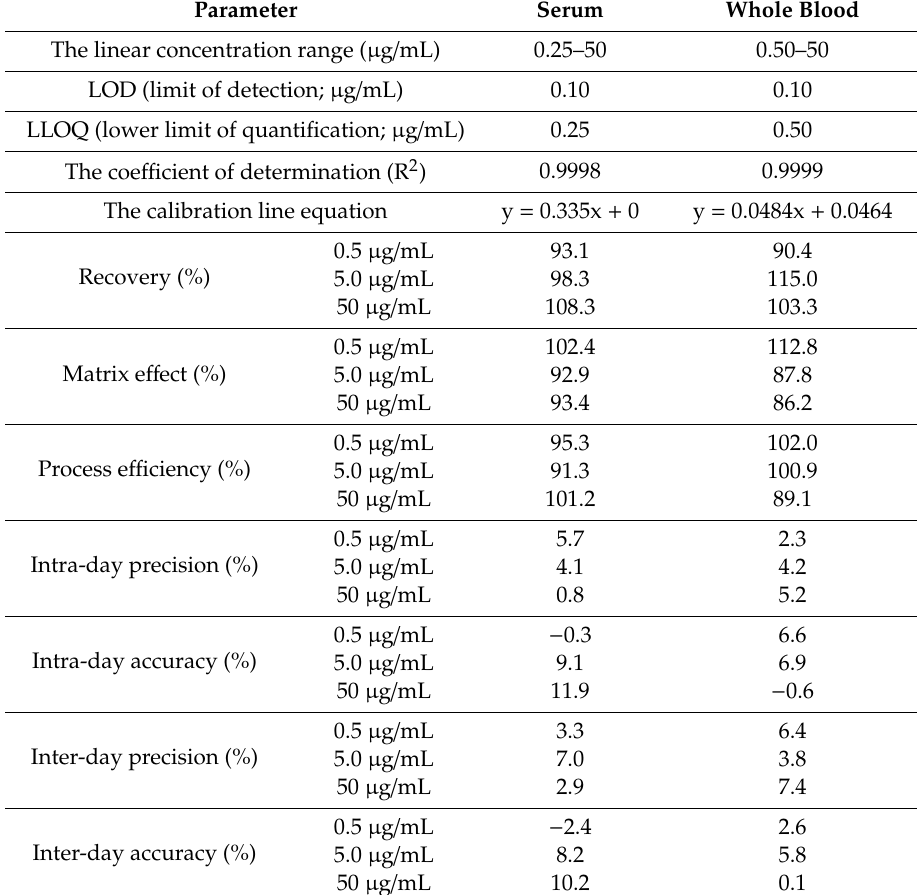
Table 5. Validation parameters of the method for determining